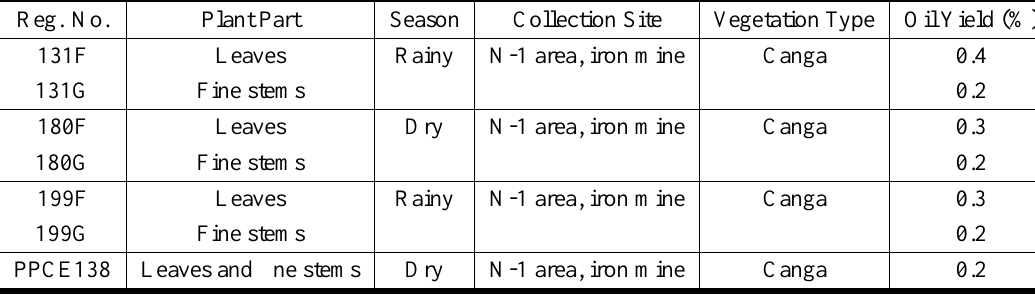
Collection data and oil yields of the samples of Pilocarpus microphyllus